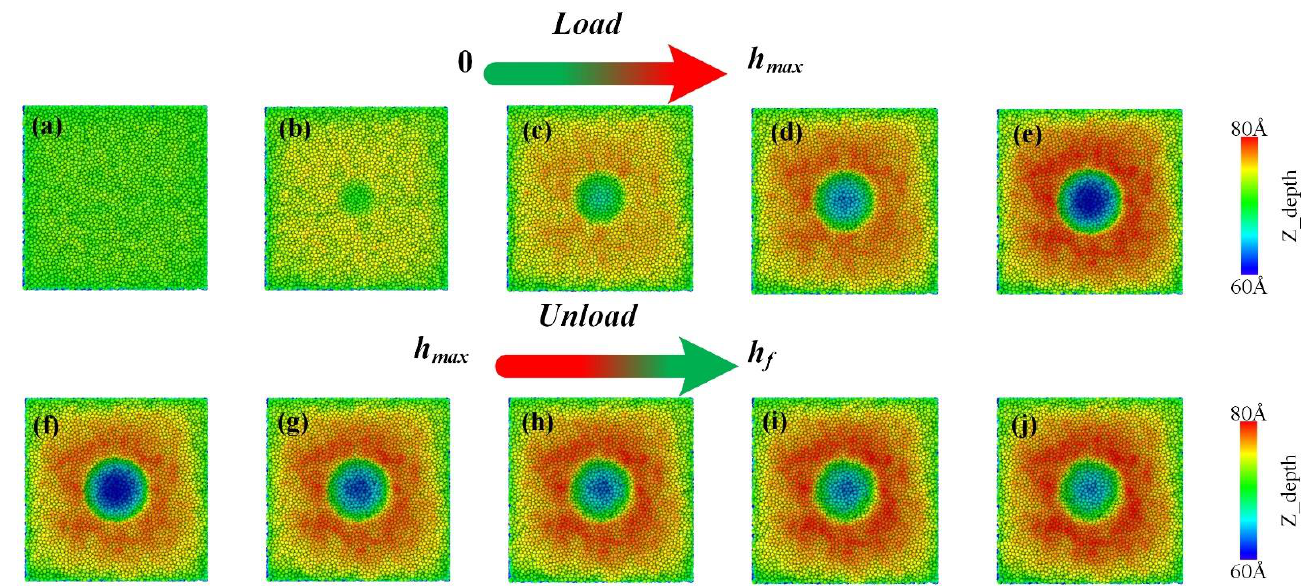
Figure 9. Dynamic loading and unloading process. ( a – e ) represent the process of load increase, ( f – j ) represent the process of unloading. The atoms are colored according to the depth in the loading direction (Z direction).